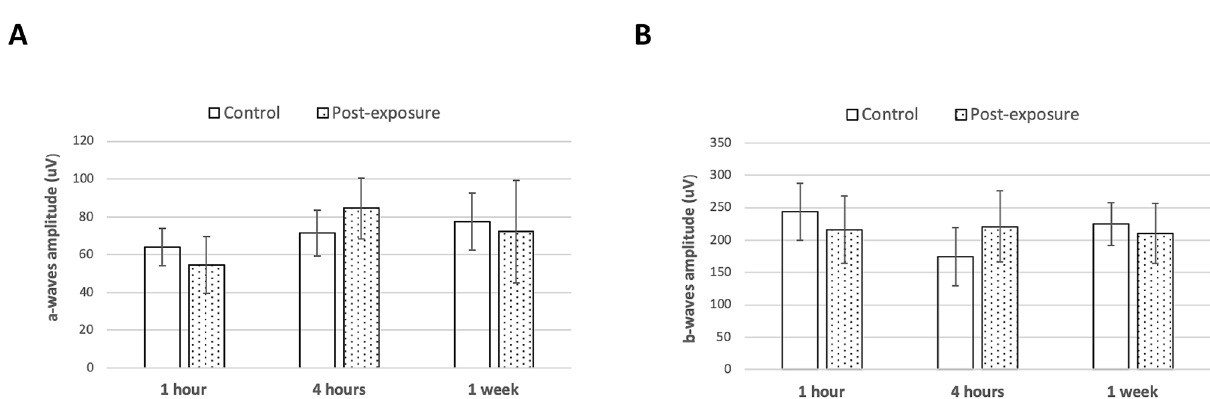
Figure 5. ERG responses after different duration of THz exposure. There were no significant changes in the scotopic a-wave ( A ) and b-wave ( B ) amplitudes after exposure compared to